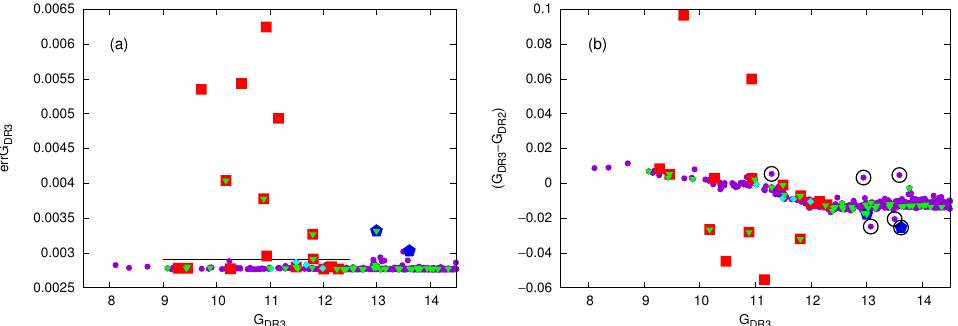
Figure 1. Data for NGC869/NGC884. ( a ) Error in the G DR 3 band versus G DR 3 magnitude. ( b ) (G DR 3 -G DR 2 ) versus G DR 3 . Violet small symbols indicate cluster members, and red squares indicate known Be stars, cyan symbols indicate stars classified as eclipsing binaries, green triangles are pulsating variable stars. Blue penthagons belong to the RS Canum Venaticorum class. The open black circles enclose objects that depart significantly from the tight relation for stable